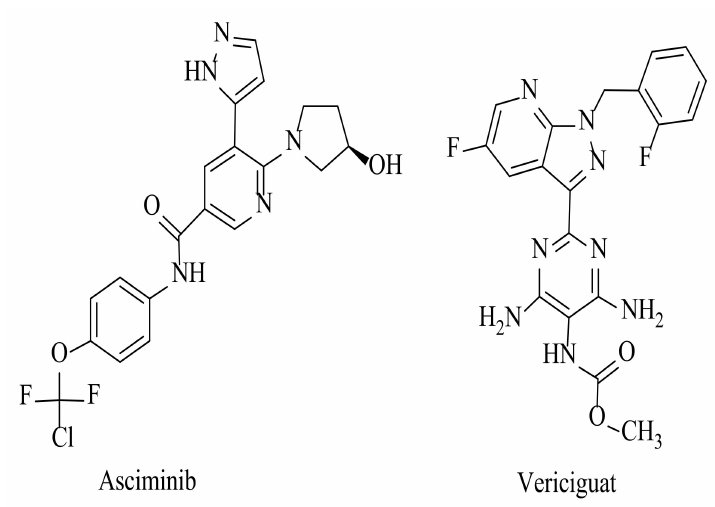
Figure 3. Structure of approved drug with pyrazolopyridine